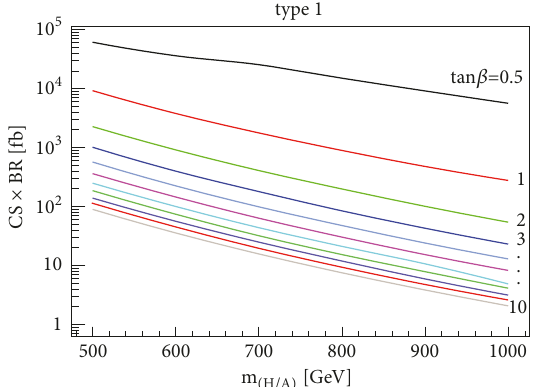
Figure 3: The signal cross section times BR (𝐻/𝐴 󳨀→ 𝑡𝑡) at √𝑠 = 14 TeV as a function of the Higgs boson mass.